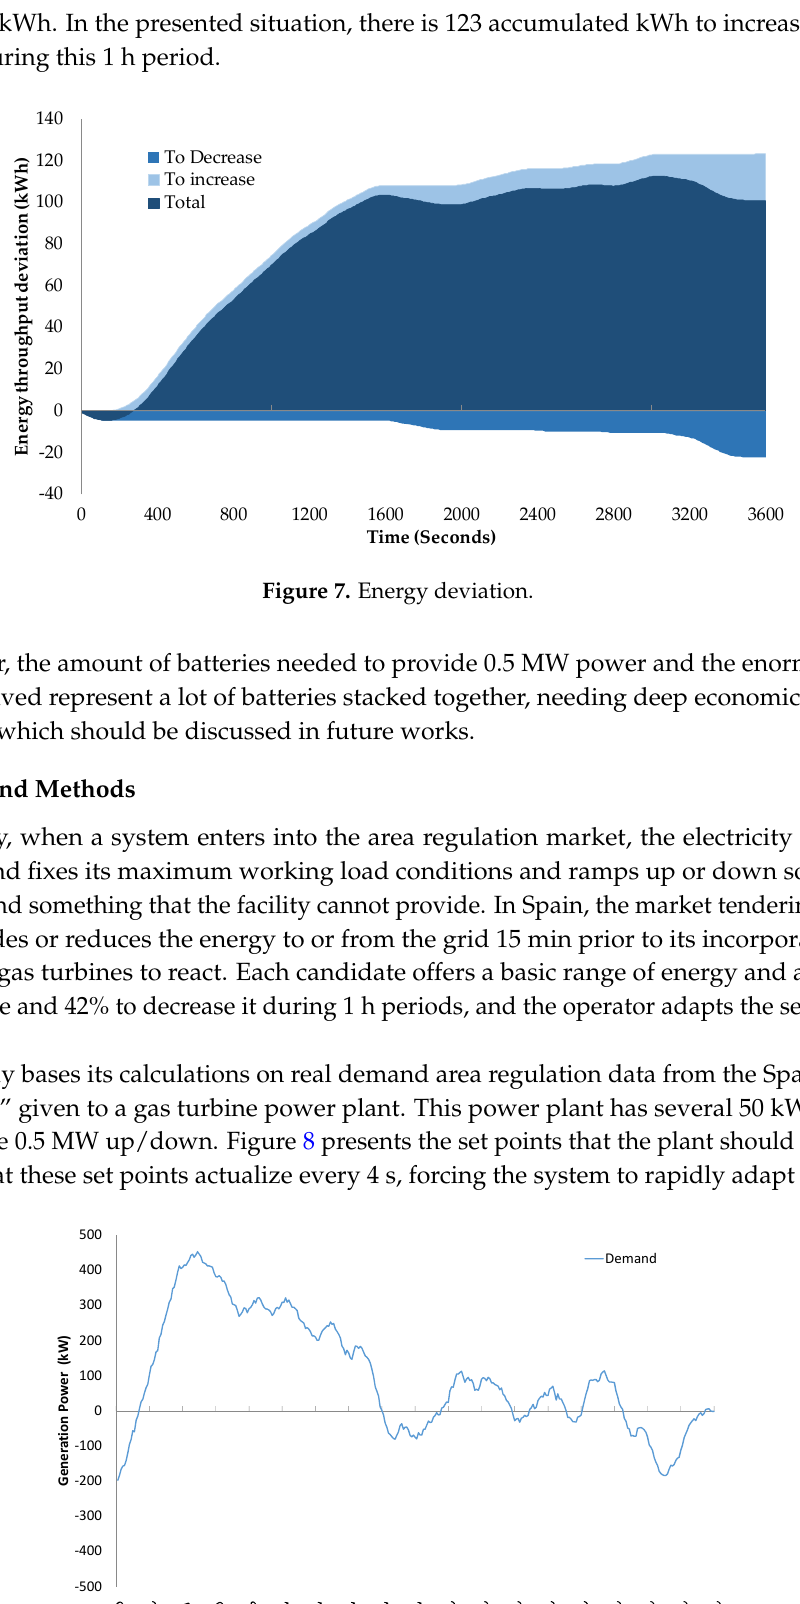
Figure 8. Set points fixed by the electricity grid operator that the generation plant should follow.